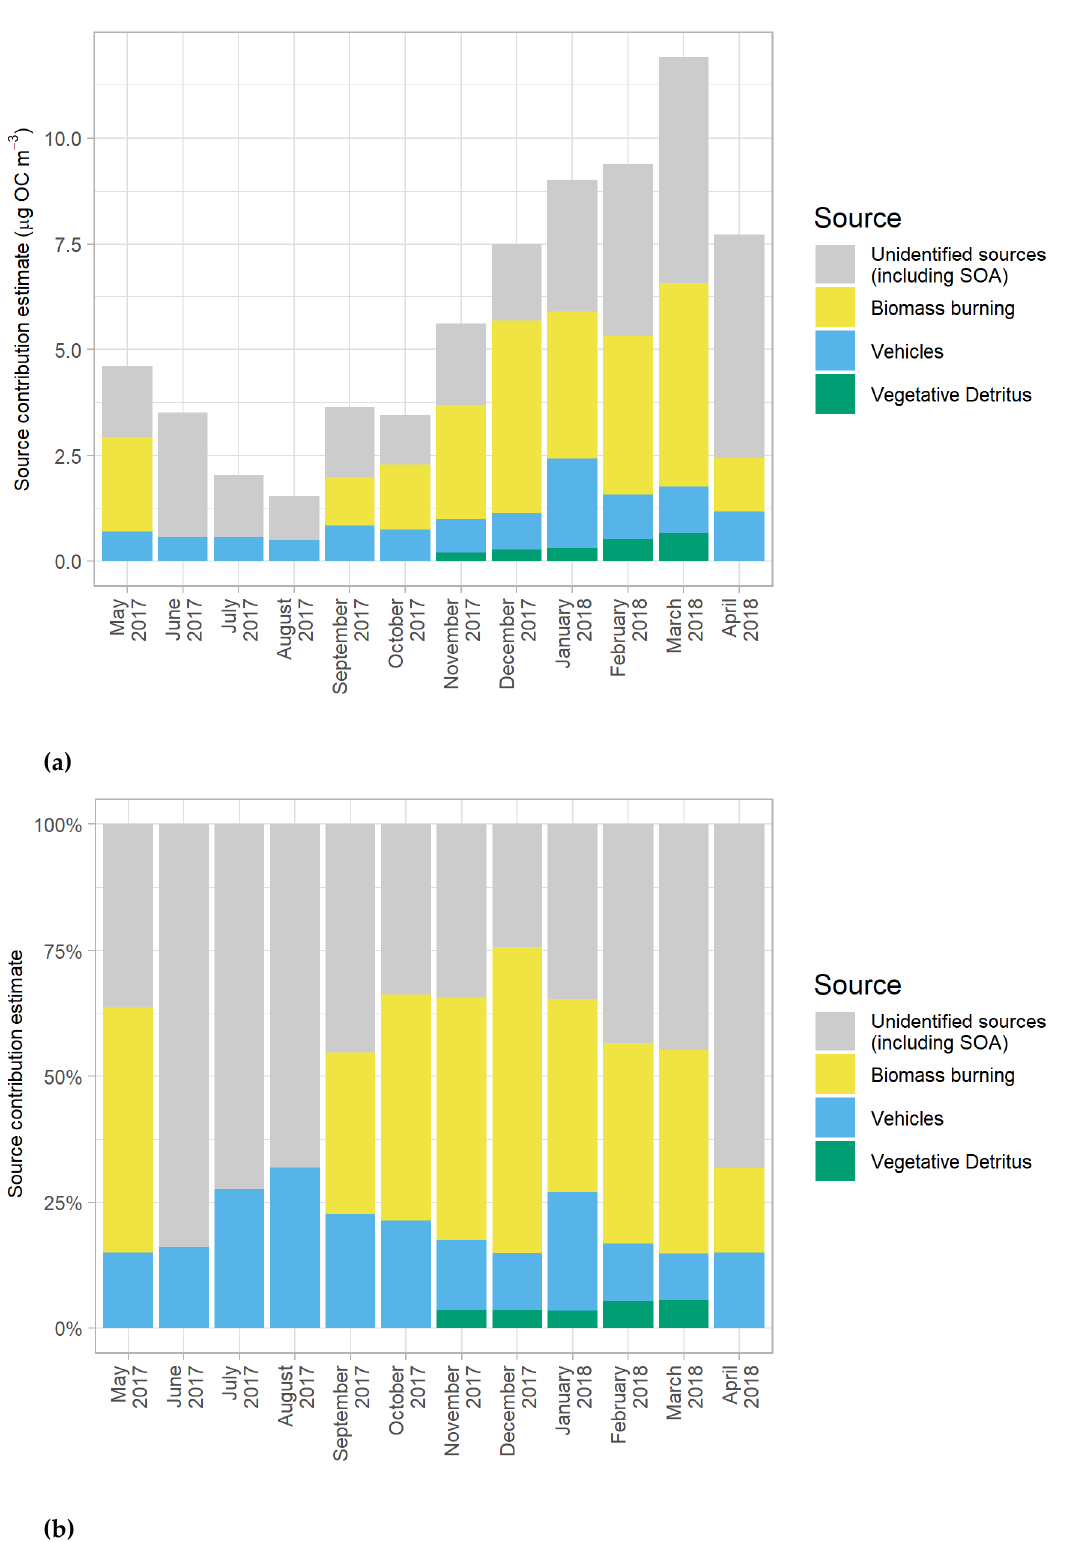
Figure 8. (a) Monthly source contributions to PM 10 organic carbon (OC) on absolute scales estimated using the Chemical Mass Balance (CMB) model in Yangon, Myanmar; (b) Monthly source contribution to PM 10 OC on percent scales estimated using CMB model in Yangon, Myanmar. Biomass burning and vehicles were the major sources contributing to identified OC in coarse particulate matter in Yangon, Myanmar, from May 2017 to April 2018. The contribution from biomass burning started to increase in September 2017, reached the highest point of 4.6 0.4 µg/m 3 in